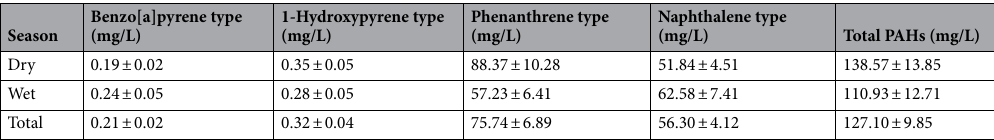
Table 1. Concentration of polycyclic aromatic hydrocarbon metabolite types (means ± SE) in thumbprint emperor sampled at Vueti Navakavu LMMA during the dry (N = 31 fish) and wet (N = 22 fish) seasons in Fiji.